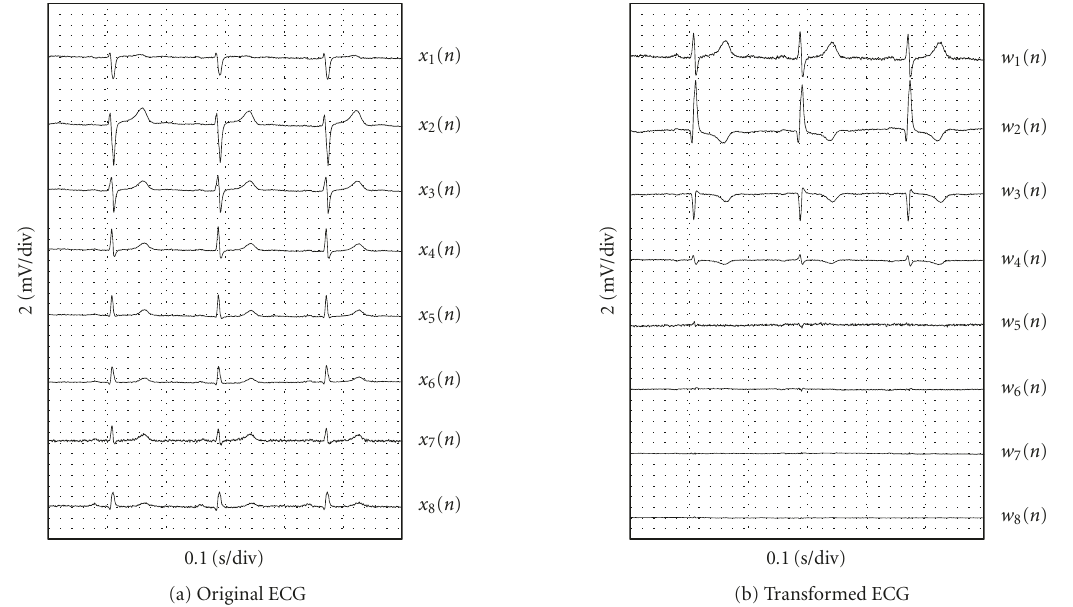
Figure 4: (a) The standard 12-lead ECG ( V 1 , ... , V 6 , I , and II from top to bottom) and (b) its KL transform, obtained using (28), which concentrates the signal energy to only three of the